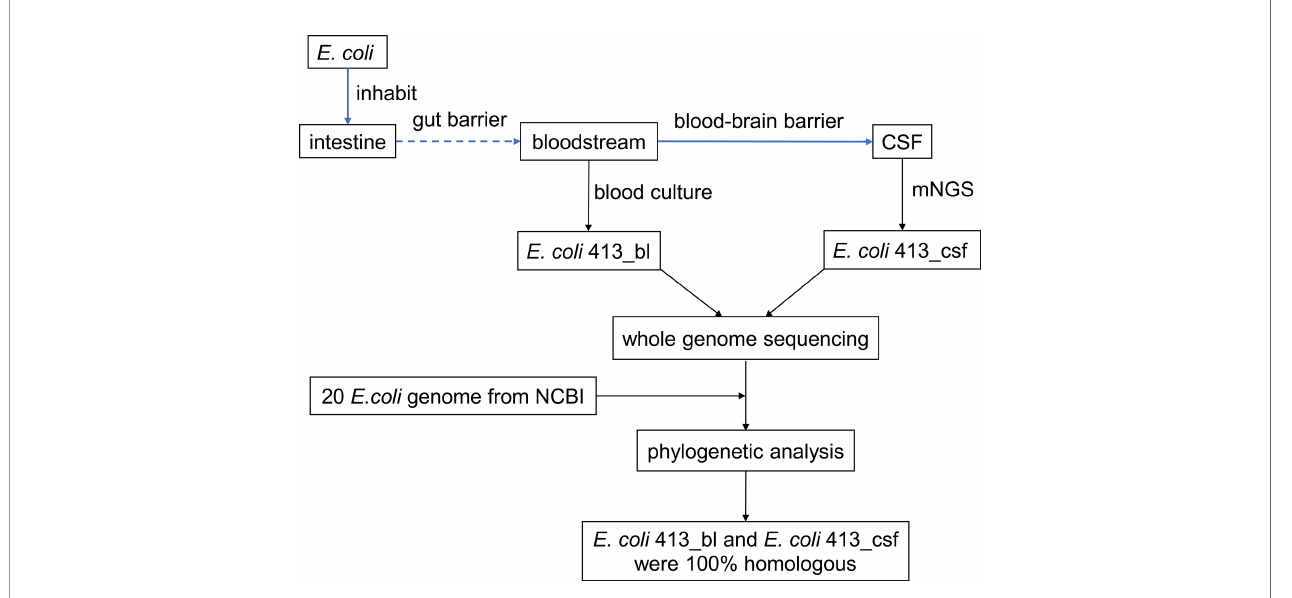
FIGURE 1 | Study design and fl ow diagram. CSF, cerebrospinal fl uid; mNGS, metagenomic next-generation sequencing; NCBI, National Center for Biotechnology